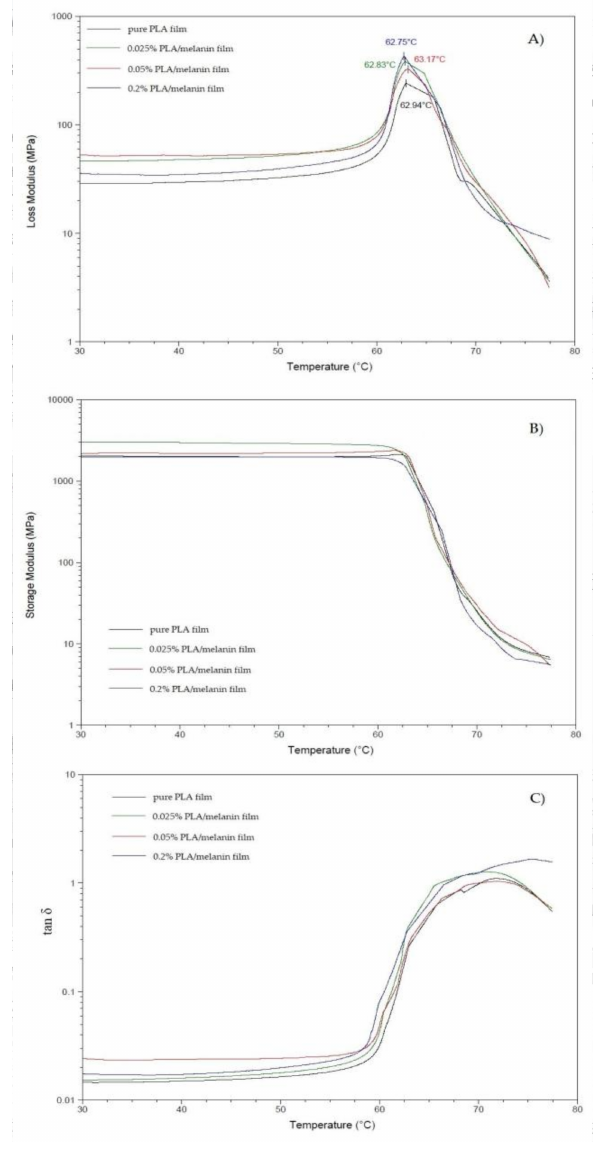
Figure 1. Loss modulus ( A ); storage modulus ( B ) and tan δ ( C ) of pure poly(lactic acid) (PLA) and PLA/melanin modified